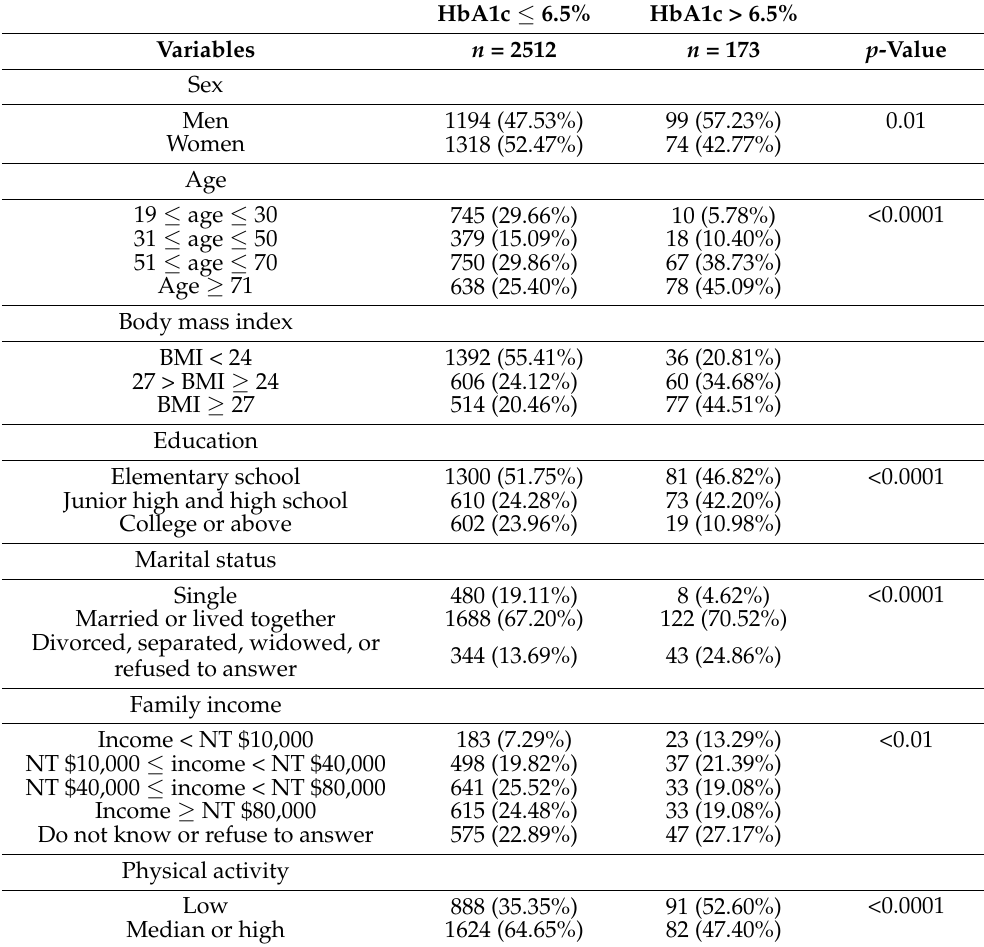
Table 1. Demographic descriptions of included study participants ( n = 2685). HbA1c ≤